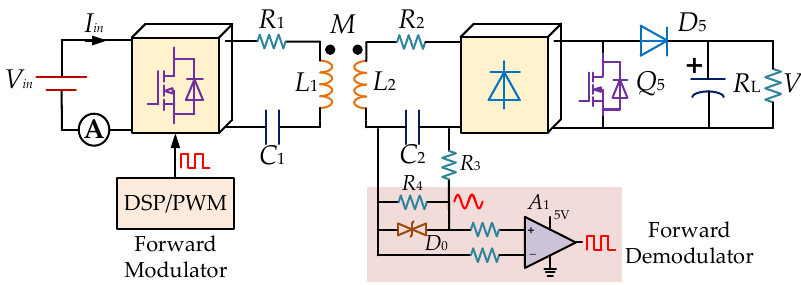
Figure 4. Structure diagram of information forward transmission.